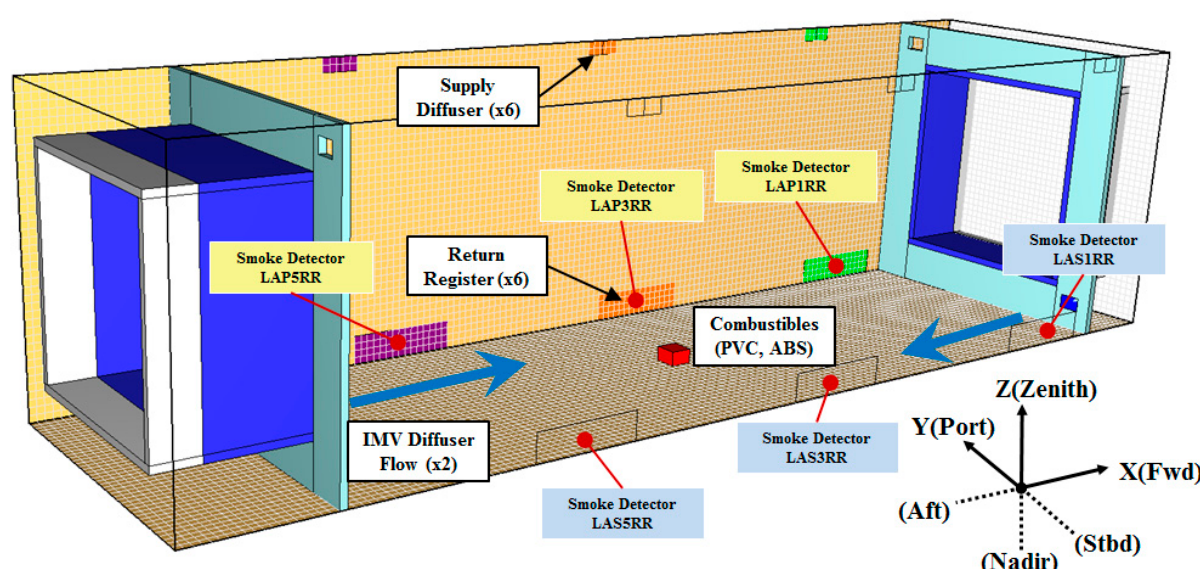
Figure 3. ISS Destiny Laboratory model showing main section, endcones, and hatches enclosed within a rectilinear grid. There are six overhead supply diffusers, six deck return registers, and one aft-port IMV diffuser for air ventilation. Induced flow patterns are indicated with lines.